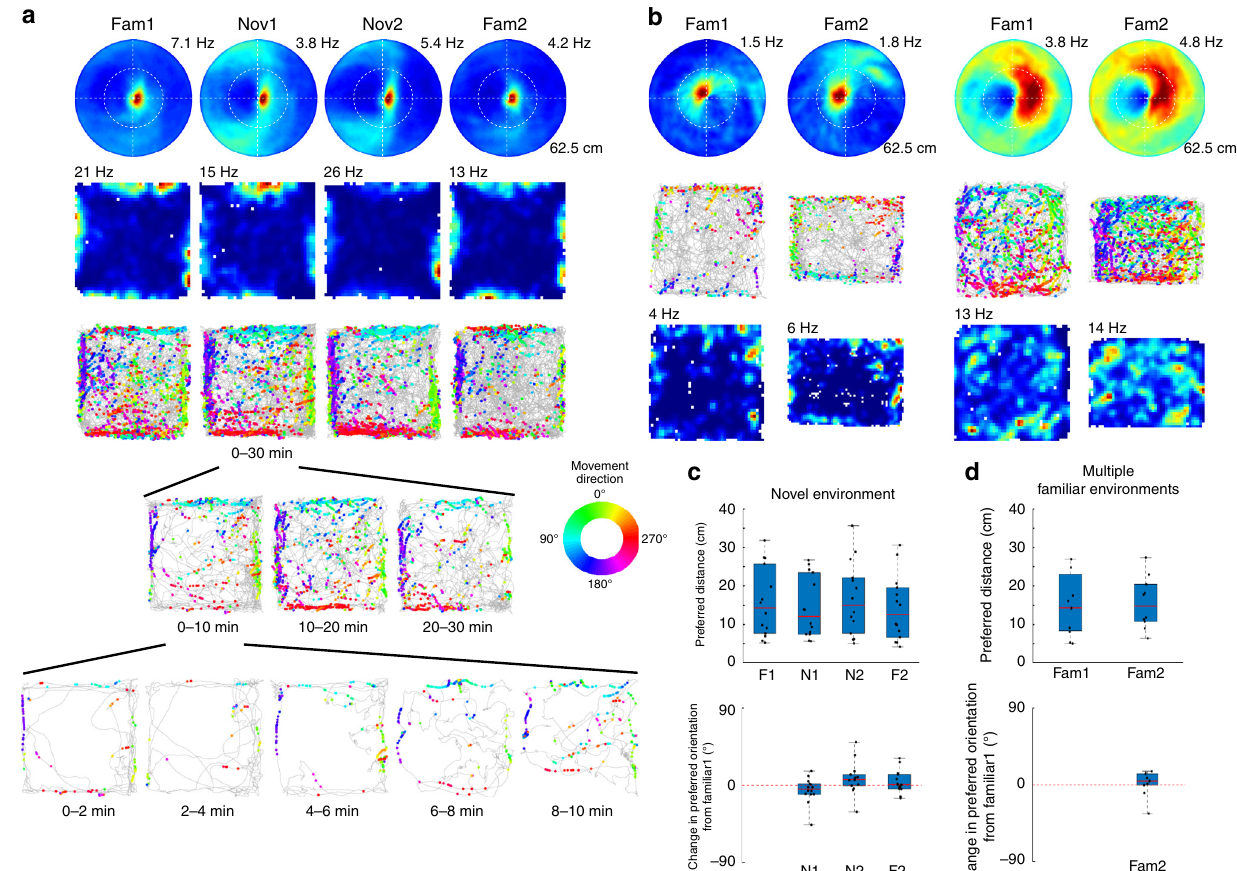
Fig. 4 Egocentric boundary cells (EBCs) do not remap across environments. a Egocentric boundary ratemaps with maximum fi ring rates indicated above each plot, allocentric spatial ratemaps with maximum fi ring rates indicated above each plot, and trajectory plots with color-coded movement direction spike locations (top to bottom) for an EBC recorded in a familiar and novel environment (left to right). b Egocentric boundary ratemaps with maximum fi ring rates indicated above each plot, trajectory plots with color-coded movement direction spike locations, and allocentric spatial ratemaps with maximum fi ring rates indicated above each plot (top to bottom) for two example EBCs recorded in different familiar environments. c Box plots of preferred distance (top) and change in preferred orientation from baseline (bottom) where the top and bottom of each box represent the fi rst and third quartile, the red line indicates the median and the whiskers indicate the full range of values for the novel environment experiment (preferred distance: Fam1: 25th: 7.68,